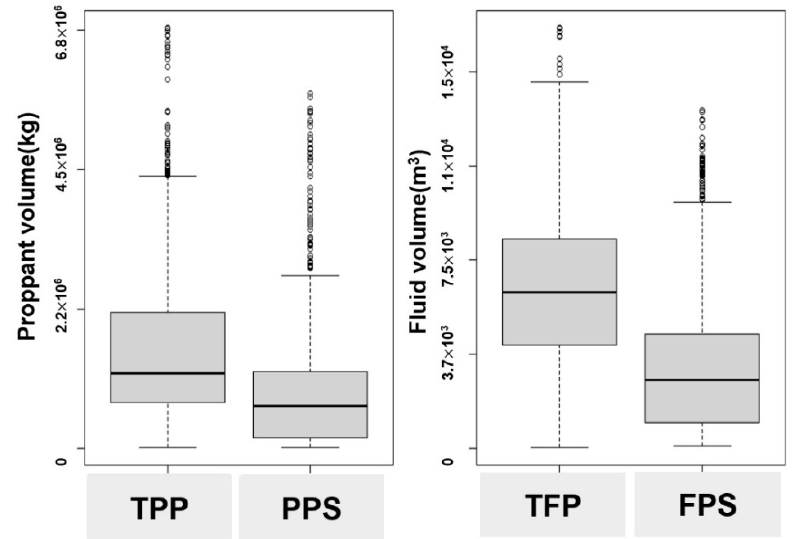
Figure 4. A box plot analysis of hydraulic fracturing related parameters.